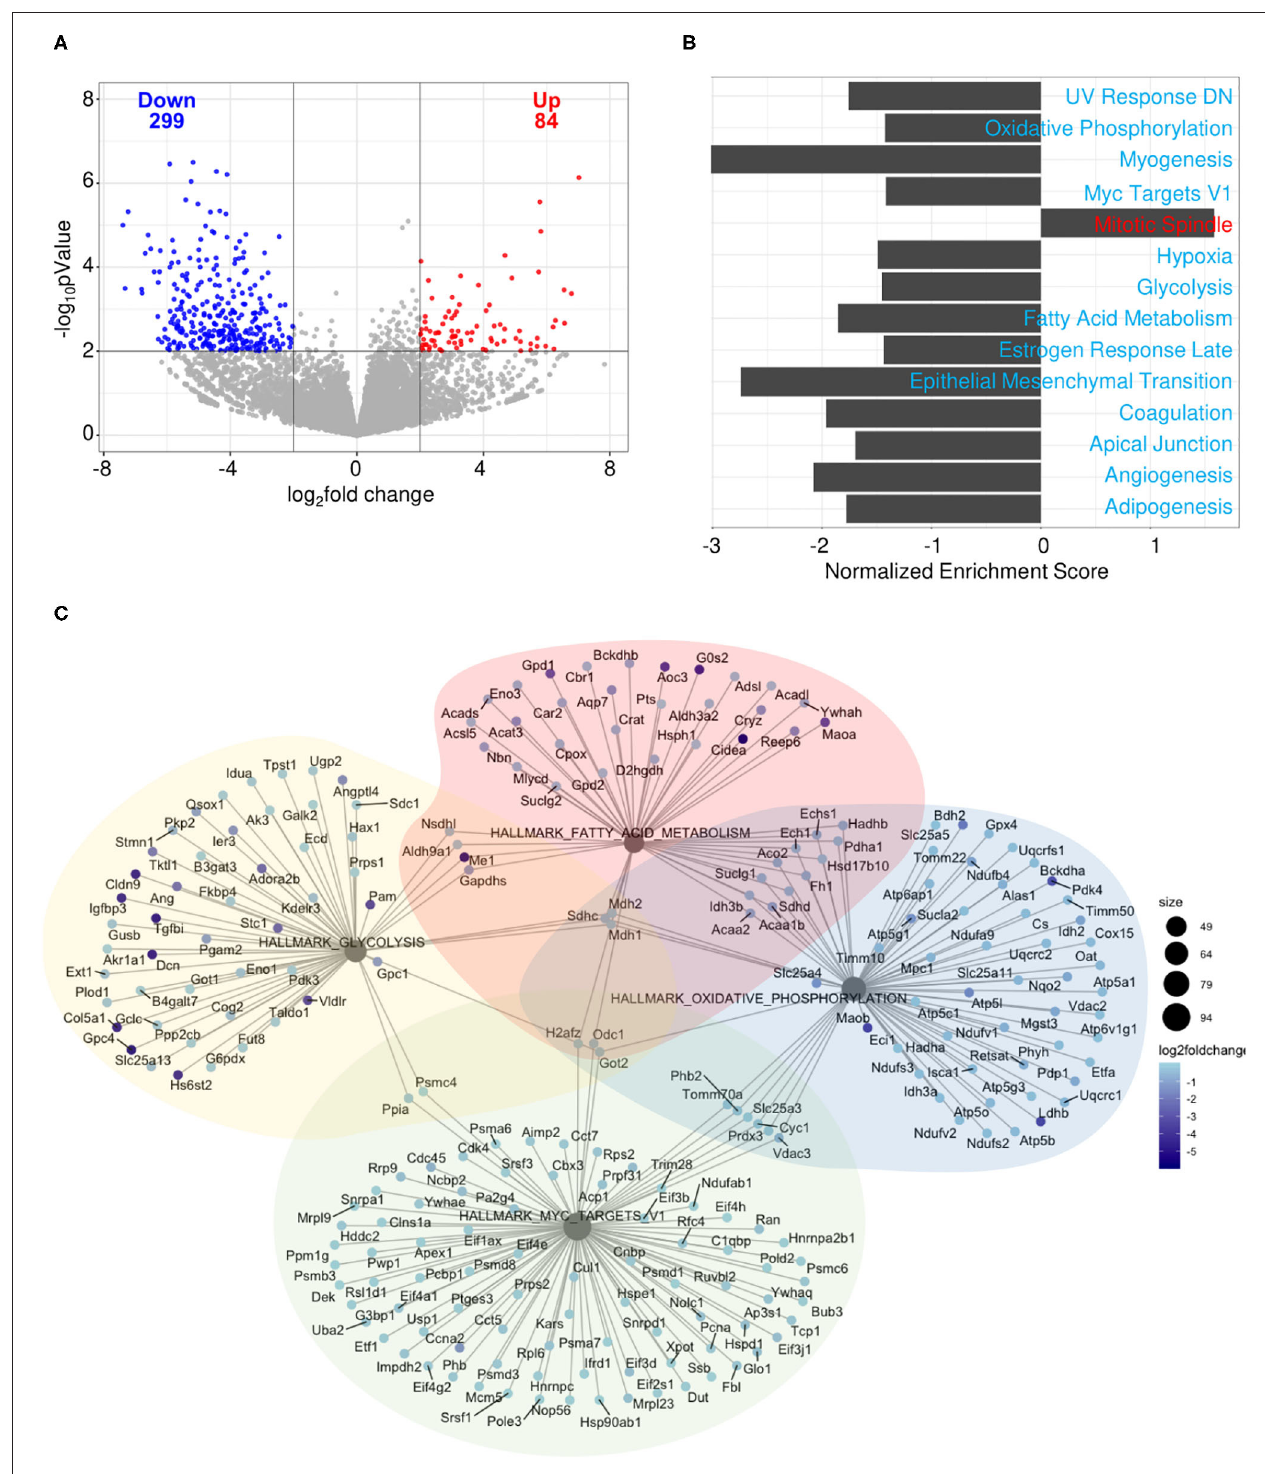
FIGURE 10 | Splenic plasmablasts derived from pregnant mice downregulate metabolic gene expression. Splenic plasmablasts from pregnant and non-pregnant infected control mice at 10 DPI were sequenced and (A) upregulated and downregulated genes identified based on an adjusted p -value threshold of 0.01 and log2 fold change threshold of 2. Each dot represents one gene. The vertical line is drawn at 0 fold change, while the horizontal line is at the log10 ( p -value = 0.01). Gene-set enrichment analysis (GSEA) (B) was performed using the hallmark gene sets from the MSigDB collection. Genes were ranked based on log2 fold change/standard error prior to running GSEA in pre-ranked mode, with padj < 0.05. Network plot (C) of gene sets involved in cellular metabolism. The size of each node represents the size of the gene set. Each gene is colored based on the log2 fold change. * p < 0.05.